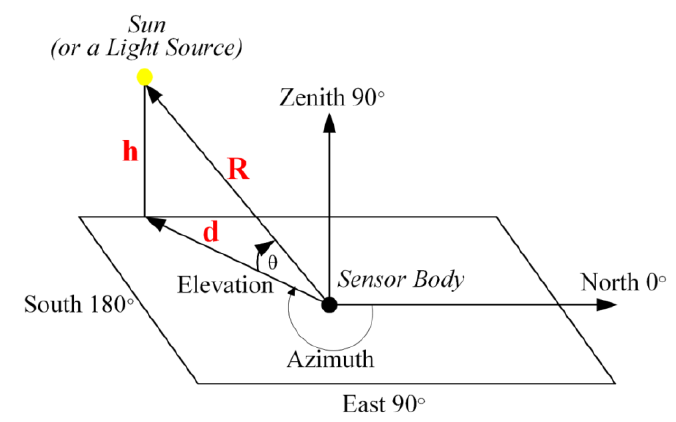
Figure 6. Relationship Between Sun and Reference Point.